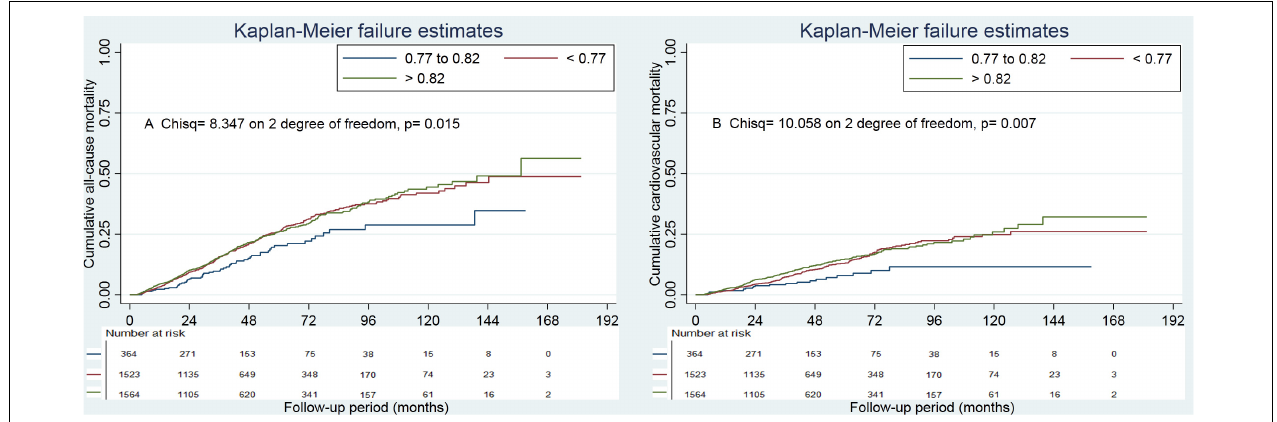
FIGURE 2 | Cumulative mortality by categories of albumin to total cholesterol ratio. Panel (A) showed cumulative all-cause mortality by categories of albumin to total cholesterol ratio. Panel (B) showed cumulative cardiovascular mortality by categories of albumin to total cholesterol ratio.